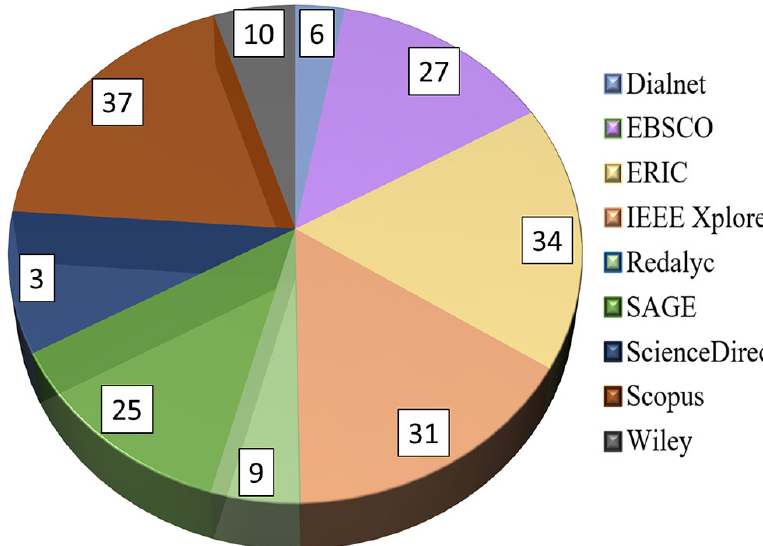
Fig. 3. Number of items collected by database